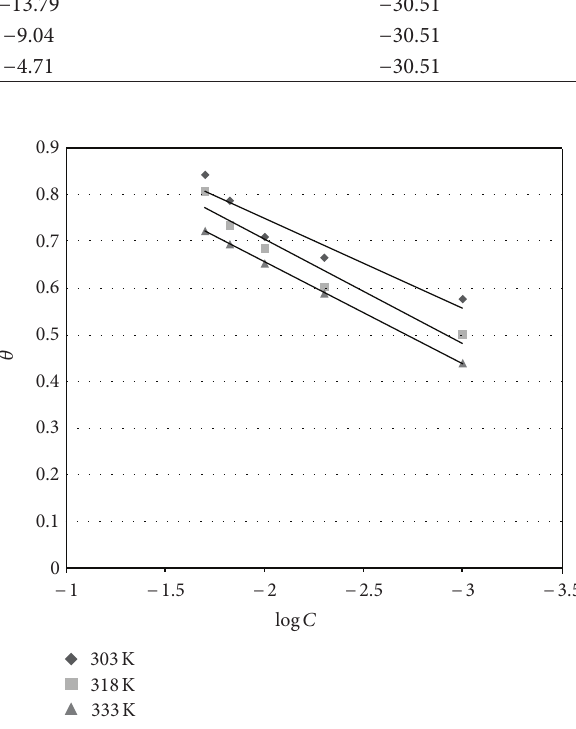
F 5: Tempkin adsorption isotherm plot for mild steel in 1N SO with H 2 4